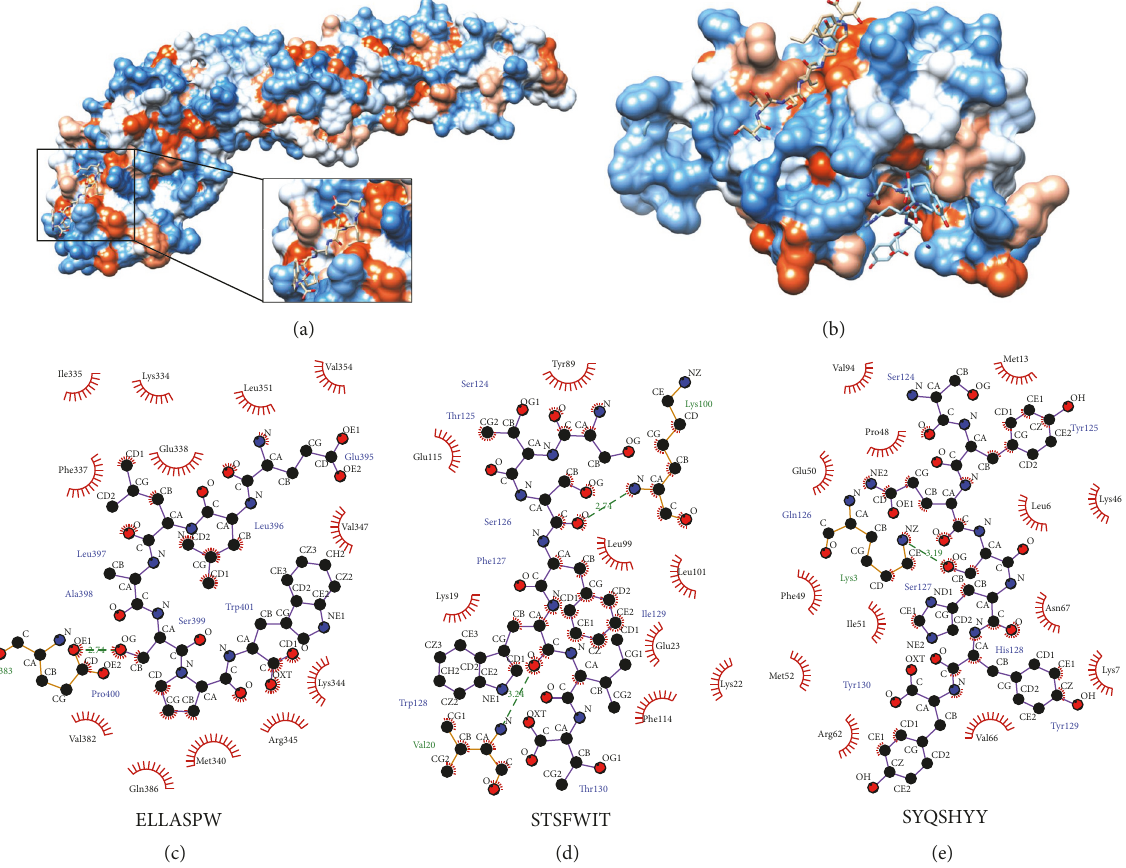
Figure 6: Probable binding modes of active peptides on their targets, as explored by molecular docking simulation. (a) Most favorable pose of peptide ELLASPW on the DENV2 envelope. Inset shows more details of putative binding site. (b) Most favorable poses of peptides STSFWIT and SYQSHYY on domain III. Peptide STSFWIT occupies the upper binding site of the molecule in this diagram. Proteins are depicted in their hydrophobicity surfaces, while peptides are in stick model. (c) Interaction diagram for ELLASPW-envelope. (d) Interaction diagram for STSFWIT-domain III. (e) Interaction diagram for SYQSHYY-domain III. Interaction diagrams were done in LigPlot+. Intermolecular hydrogen bonds are indicated by green dashed lines, while hydrophobic interactions are represented by arcs and radiating spokes. Pose figures were prepared using UCSF